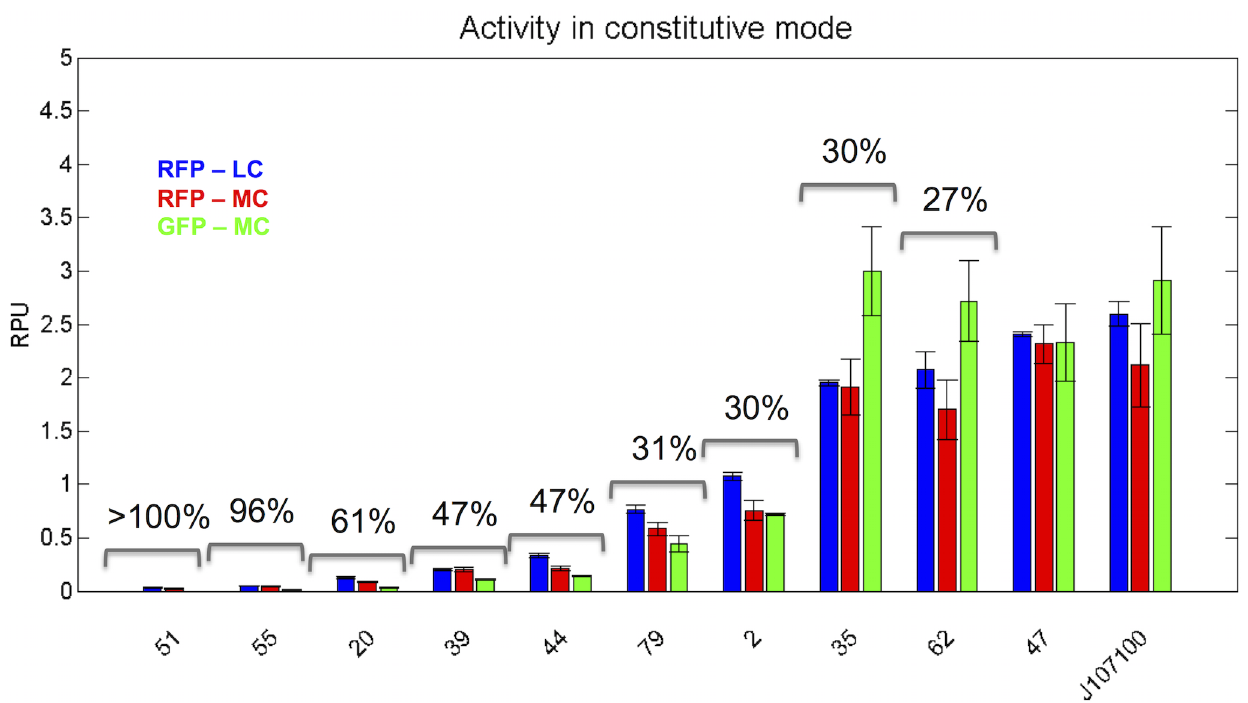
Fig 4. Constitutive activity of the LuxR-repressible promoters with three different measurement systems. Bars represent the average of at least three experimental replicates and error bars represent the 95% confidence intervals. CV is reported when a statistically significant difference was measured among the three experimental conditions (p-value < 0.05,